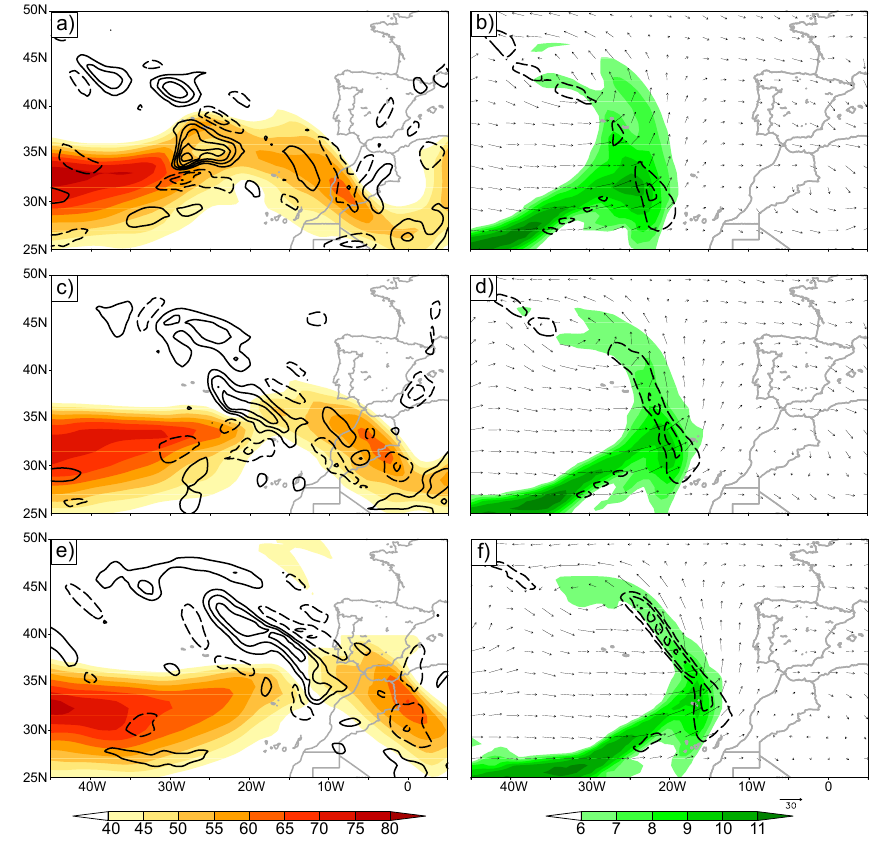
Fig. 9. (a) Wind speed (colours, units in ms − 1 ) and divergence at 250hPa geopotential level (solid lines with contours every 2 × 10 − 5 s − 1 , zero line removed), for 20 February 2010, 00:00UTC; (b) wind speed (arrows, units in ms − 1 ), specific moisture content (colours, units in 10 − 3 kgkg − 1 ) and moisture convergence (dashed lines with contours every 10 − 5 kgm − 2 s − 1, zero line removed, only negative values are shown) at 850hPa geopotential level for 00:00UTC; (c) as (a) but for 06:00UTC; (d) as (b) but for 06:00UTC; (e) as (a) but for 12:00UTC; (f) as (b) but for